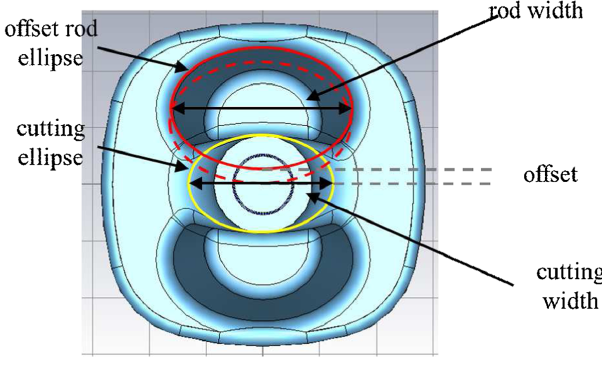
FIG. 15. Parametrization of the kidney shaped 4RCC.